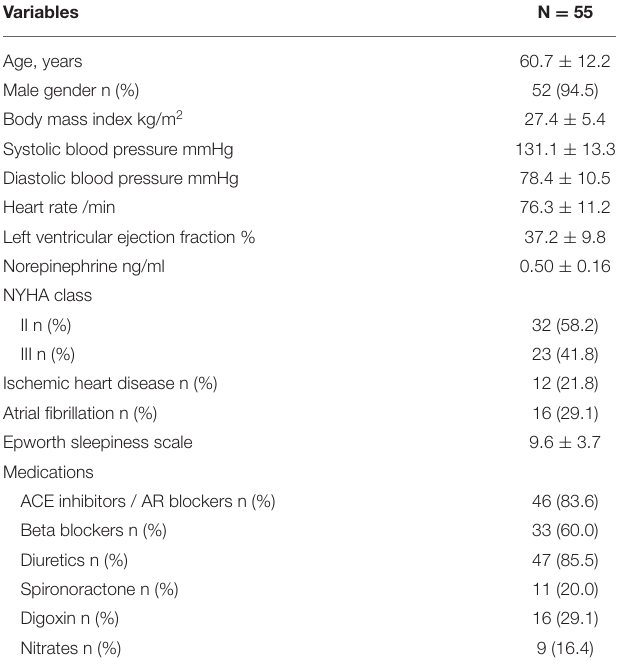
TABLE 2 | Data of sleep study. ( Figure 1 ). Significant decreases in systolic and diastolic BP and HR ( Figures 2A–C ) after treatment were noted. The serum On diagnosis norepinephrine concentration decreased, and the ESS improved were observed in BMI ( Figures 3A–C